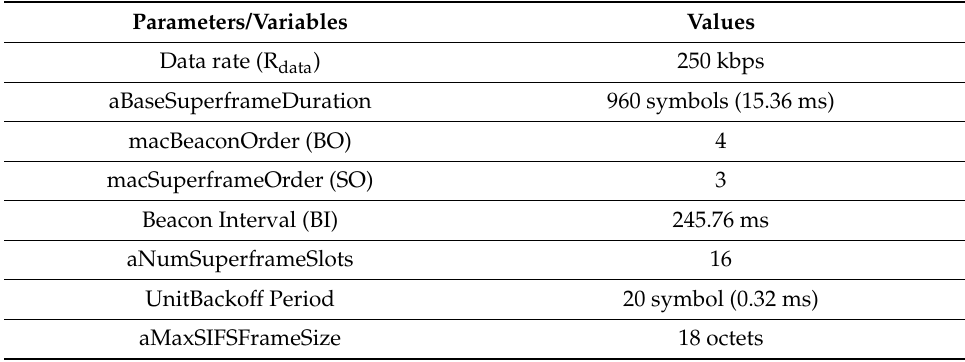
Table 2. System parameters and